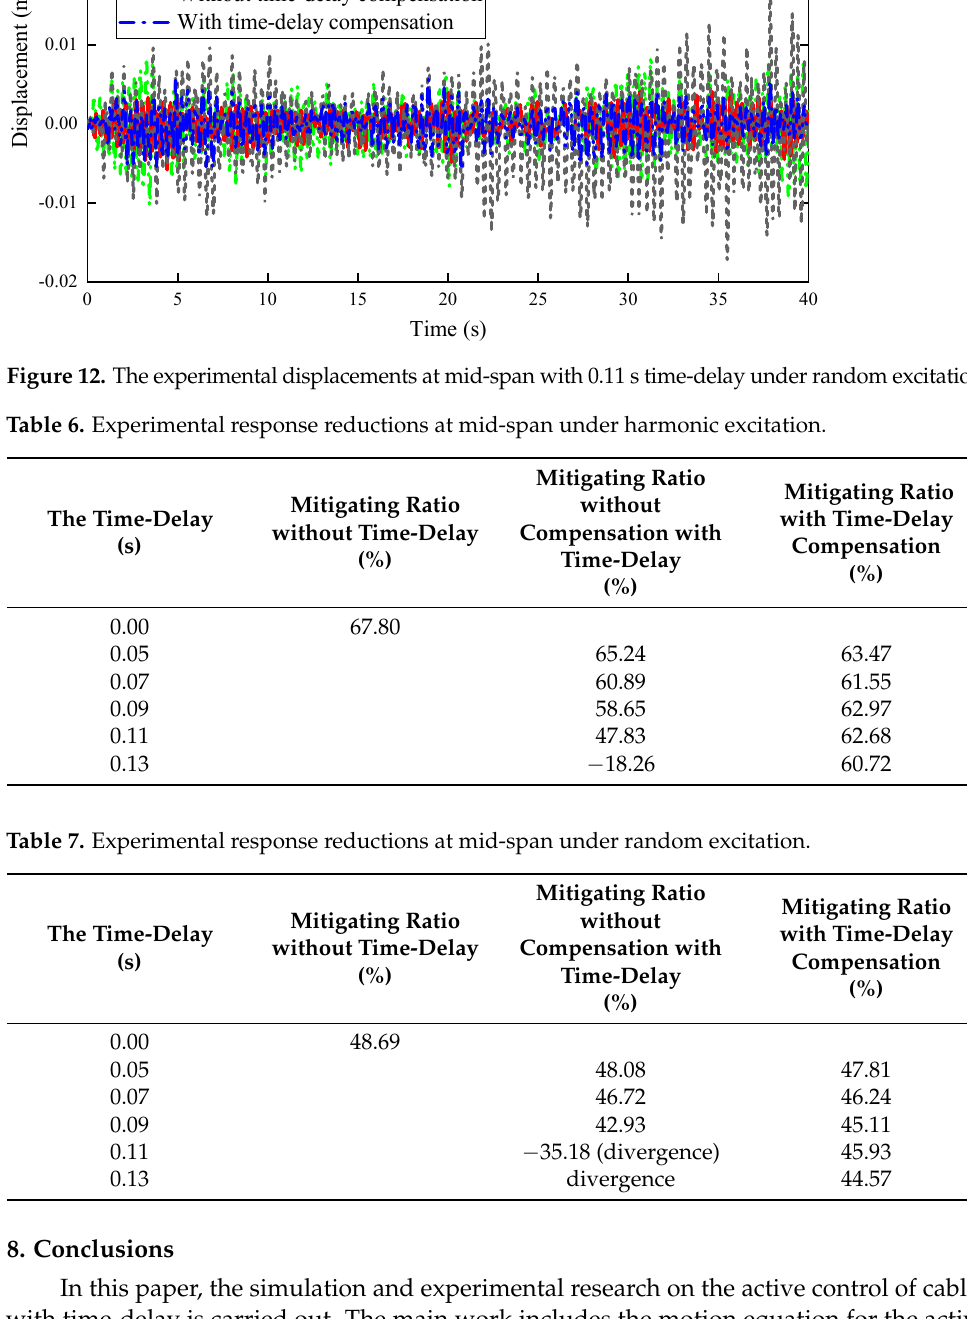
( b ) Figure 11. The experimental displacement at mid-span with time-delay under harmonic excitation. ( a ) The time-delay is 0.11 s. ( b ) The time-delay is 0.13 s. Table 6. Experimental response reductions at mid-span under harmonic excitation. The Time-Delay (s)